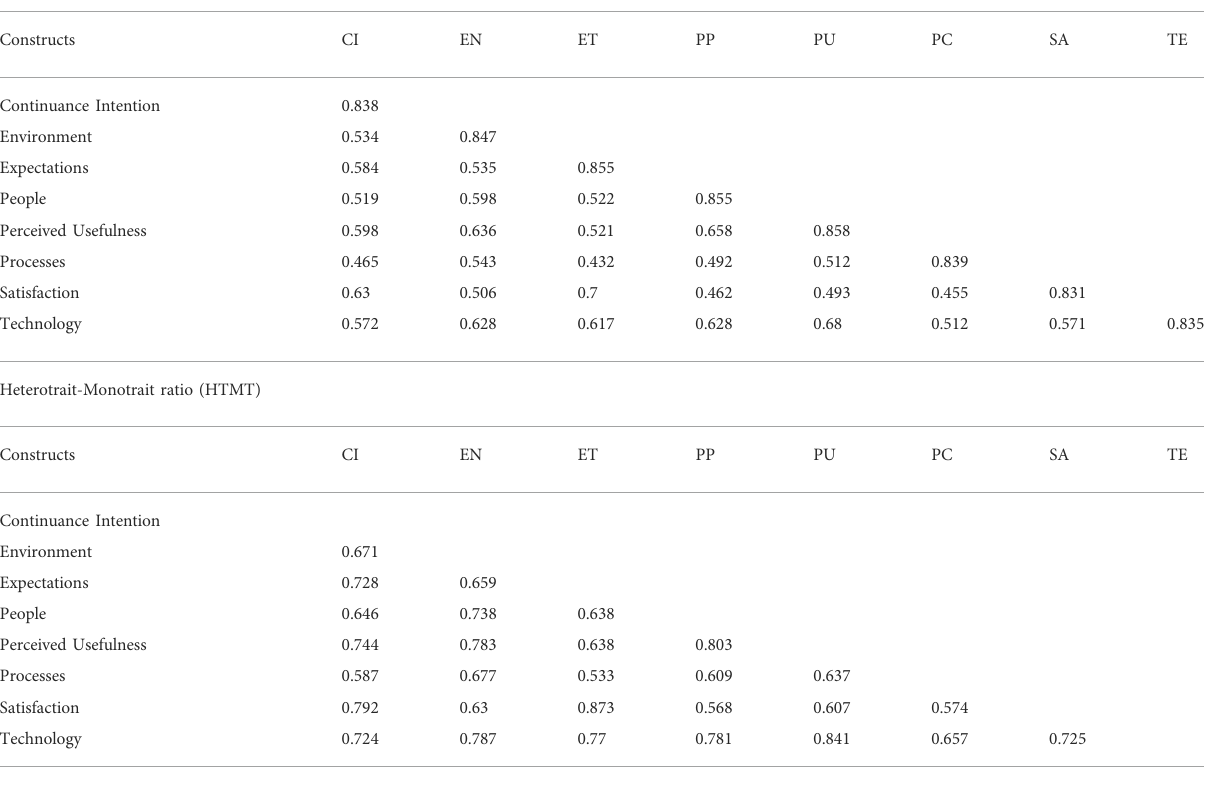
TABLE 4 Fornell-Larcker criterion and Heterotrait-Monotrait ratio (HTMT). Fornell-larcker criterion